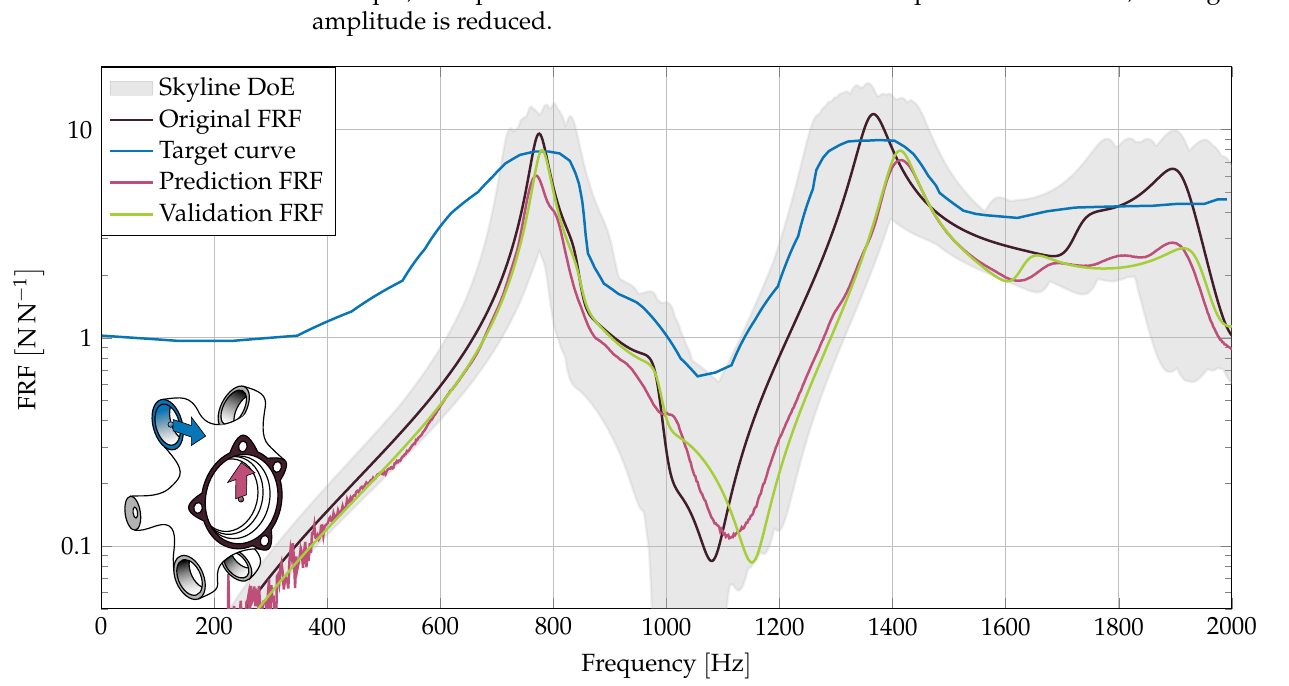
Figure 6. Optimization using a drawn maximum-curve describing a multi-objective optimization. Desired amplitude reduction at multiple frequency ranges while allowing small eigenfrequency